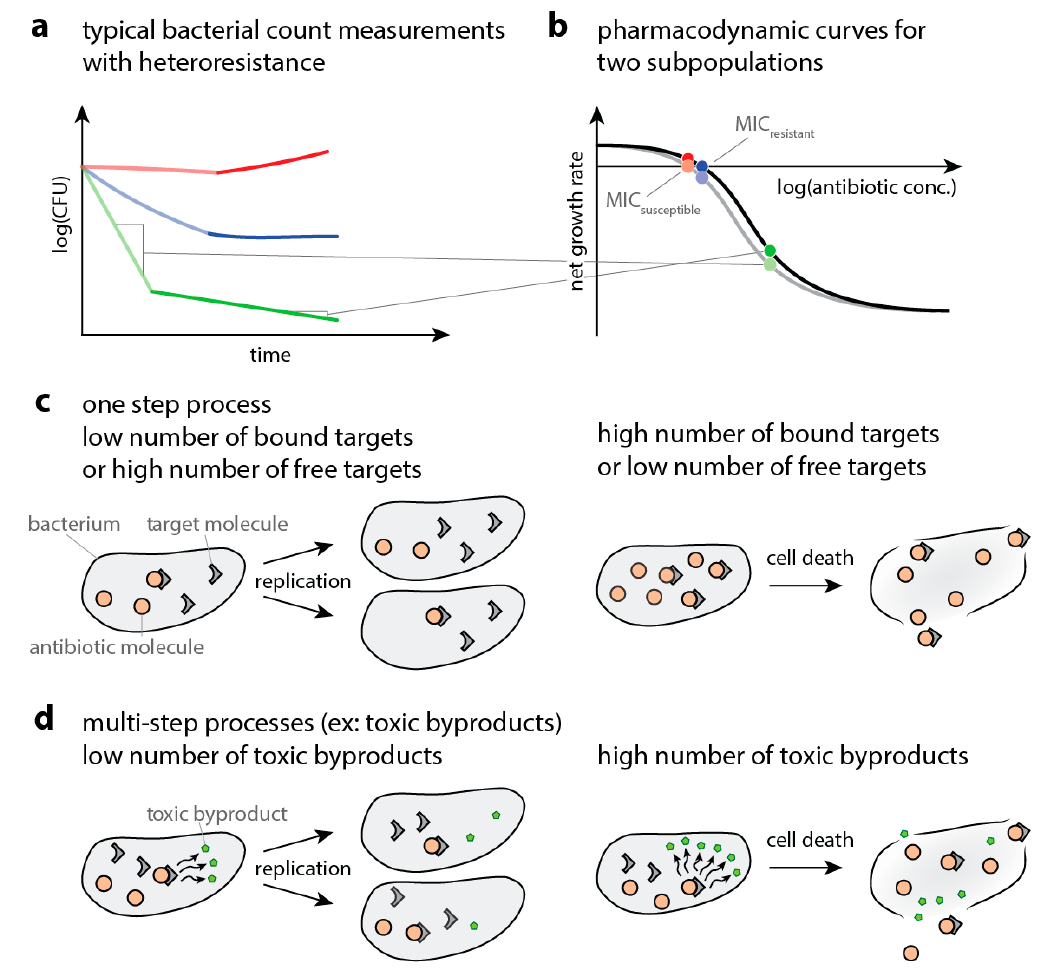
Figure 1. Schematic explanation of observed data and underlying processes. ( a ) Schematic drawing of a time–kill curve, where bacterial numbers are followed over time after exposure to di ff erent antibiotic concentrations (increasing from red to blue to green). The initial fast decline is depicted in pale, the subsequent slow decline in dark colors. ( b ) Schematic of a pharmacodynamic curve showing how increasing antibiotic concentrations (di ff erent colors) a ff ect bacteria. The x-axis shows logarithm of the antibiotic concentrations. The y-axis shows the resulting net growth rate, that is., bacterial replication minus death, as measured by the slope of bacterial decline. The gray line depicts the quickly declining population (more susceptible), the black line represents the population declining more slowly. The grey lines between ( a ) and ( b ) illustrate how to translate the slope of time–kill curves to the pharmacodynamic curves. The pale and dark points illustrate the slopes of the time–kill curves in the corresponding colors in ( a ). ( c ) Schematic representation of the events leading to bacterial death if the drug-target complex itself is toxic. Bacteria can still replicate when few target molecules are bound by the antibiotic (left panel) but die when a high number of target molecules that exceed the killing threshold are bound (right panel). ( d ) Schematic representation of the events leading to bacterial death if the drug-target complex causes the accumulation of a toxic metabolite. Bacteria can still replicate when only a few metabolite molecules are present and die when too much metabolite has accumulated.